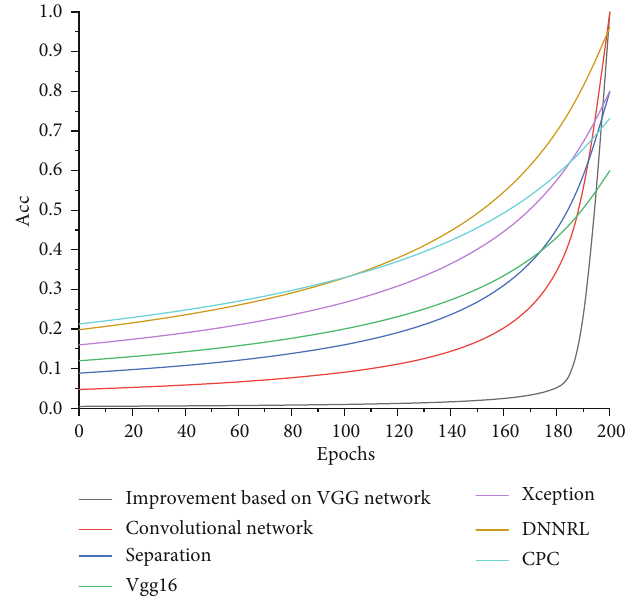
Figure 6: Accuracy curves of the two improved networks and their comparative models on the